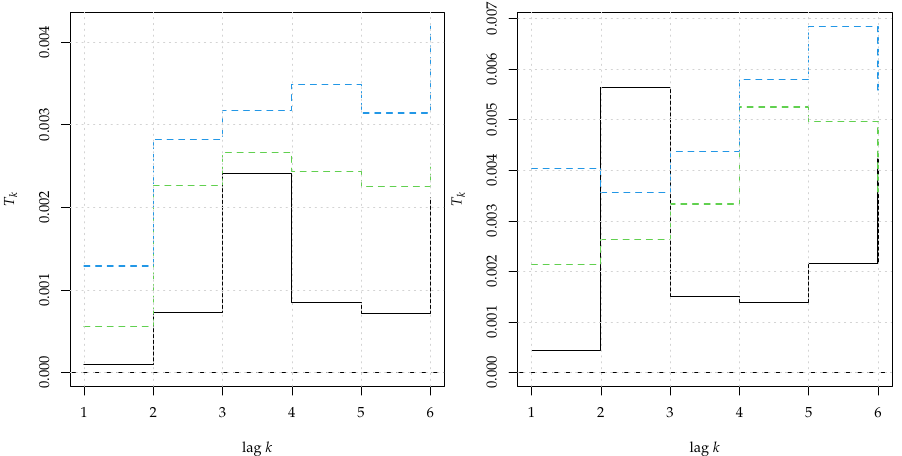
Figure 10. Test statistic T k for k = 1, . . . ,6 (black, solid line), computed on a linear Gaussian MA(1) process (left panel) and on a linear MA(1) process driven by Student’s t innovations (right panel). The rejection bands at 95% (green dashed line) and 99% (blue dashed line) correspond to the null hypothesis of a linear Gaussian